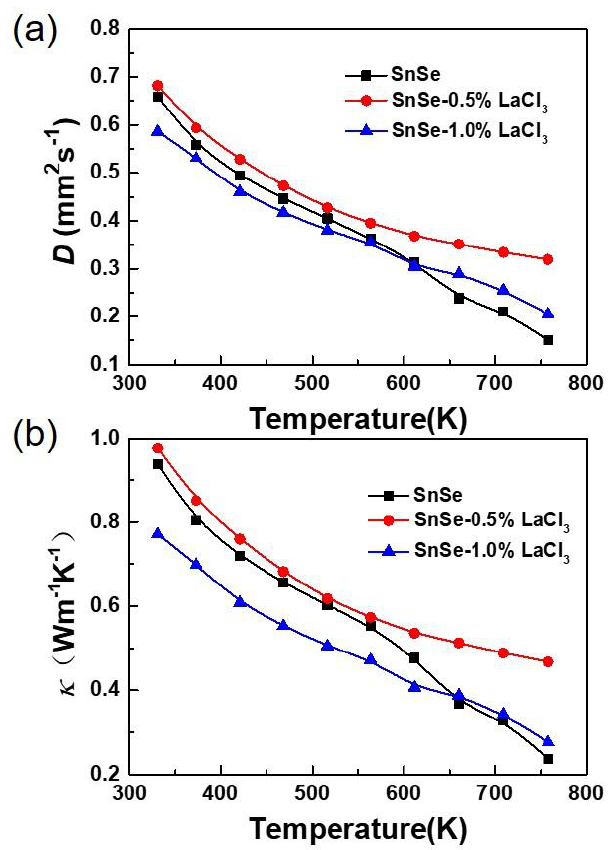
Figure 4. Thermal transport properties as a function of temperature for all the samples SnSe- x wt % LaCl 3 ( x = 0.0, 0.5, and 1.0). ( a ) Thermal diffusivity; ( b ) thermal conductivity.